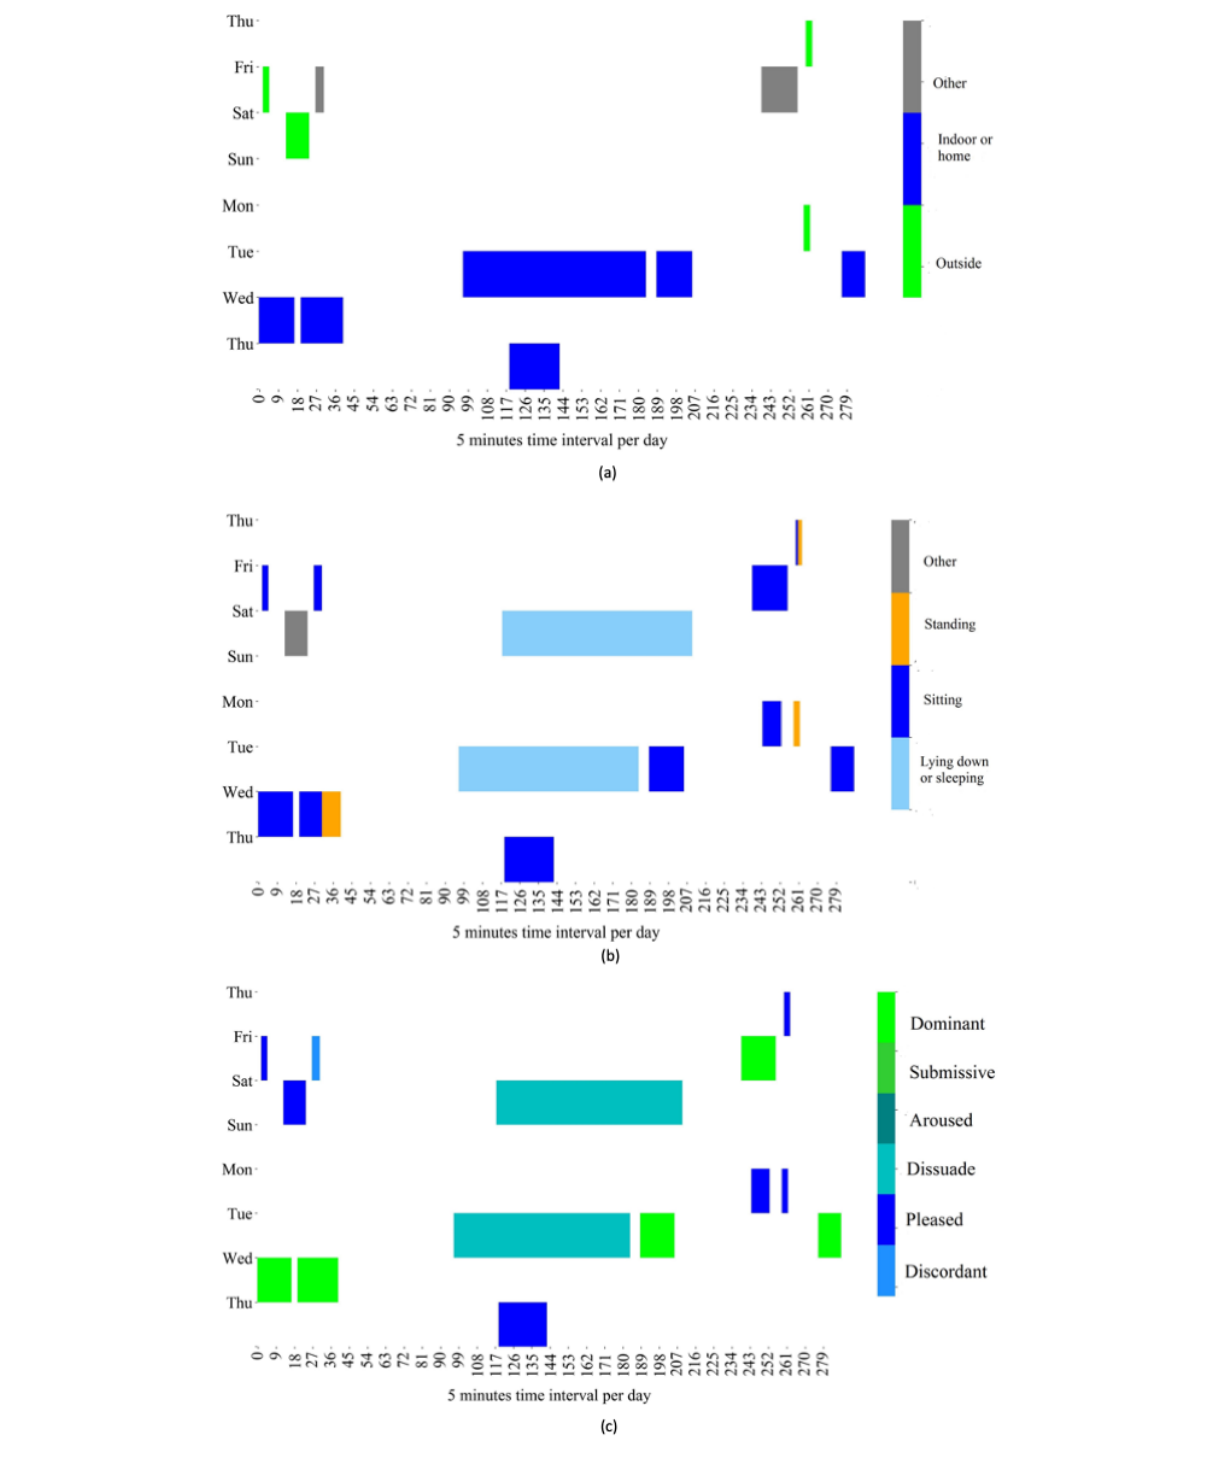
Figure 8. Daily life versus emotional states of person 9 (best case). The x-axis plots 288 windows per day, and the y-axis plots the number of days in the data collection period of person 9. The color-coded regions represent (a) spatial contexts, (b) activities, and (c) emotional states in each window over the period of data collection (8 days). The white regions represent missing